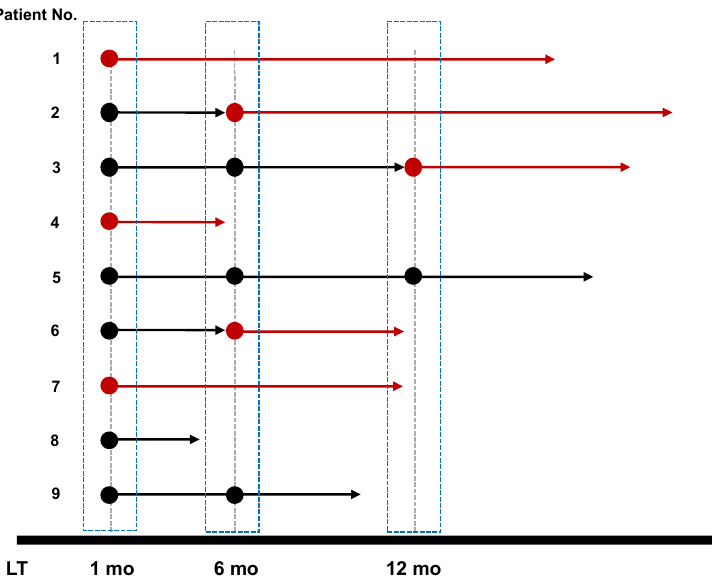
Figure 1. Graphical description of the time-based cohort for matching on the time-conditional propensity score. Round marks mean potential subjects for matching at each time point and arrows mean their follow-up. Black is for TAC/MMF combination therapy and red is for TAC monotherapy. TAC monotherapy users were matched to TAC/MMF users at a 1:1 ratio with time-conditional propensity scores which were generated with baseline- and time-varying variables measured at each time point, including Karnofsky performance status score, glucocorticoid use, liver function tests, eGFR, and infection before matched time points. TAC/MMF users who were selected as matched comparators for given TAC monotherapy users once were not considered as possible comparators in the subsequent matching process. Matched TAC/MMF users who changed to TAC monotherapy during follow-up were censored at the time of switch and included as a TAC monotherapy group in the next matching set. Both matched groups were censored if the regimen changed to another one during follow-up.